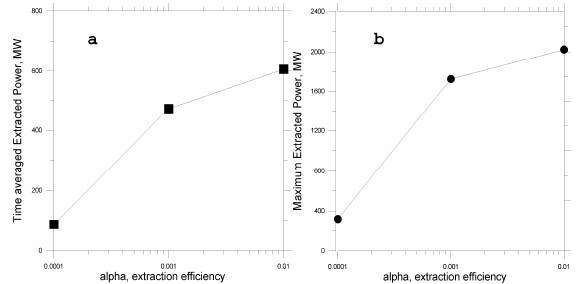
Fig.4. Mean and maximum extracted energy by the tidal energy conversion farm as a 644 Fig. 4. Mean and maximum extracted energy by the tidal energy function of the rated power capacity of the farm represented by the Rayleigh 645 conversion farm as a function of the rated power capacity of the coefficient 9 . 646 farm represented by the Rayleigh coefficient α 647